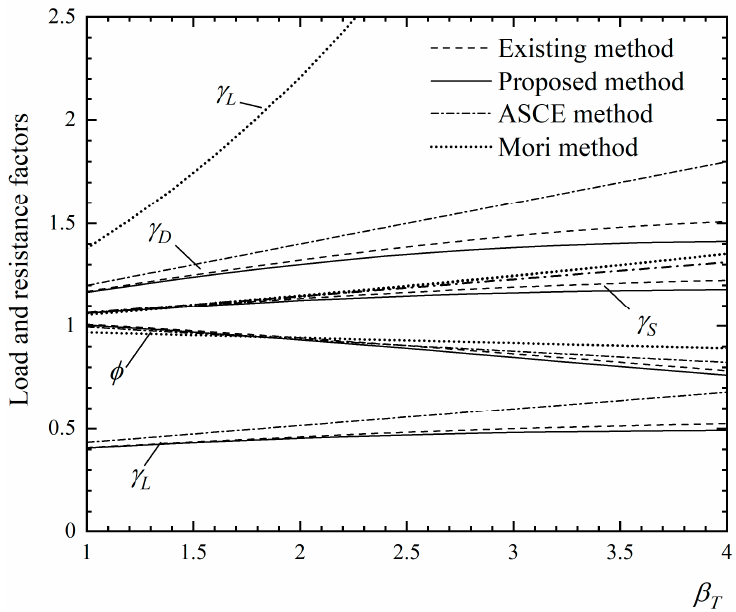
Figure 3. Load and resistance factors calculated using different methods for β T = 1.0–4.0.